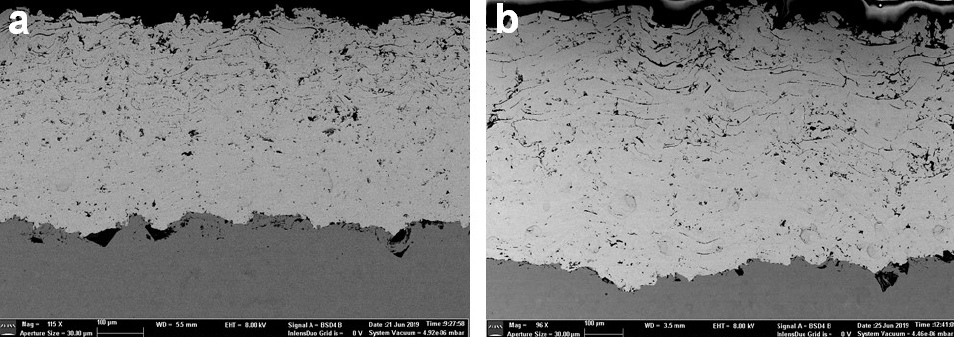
Figure 1. The SEM of Mo coatings sprayed by a) APS and b) TWAS technique